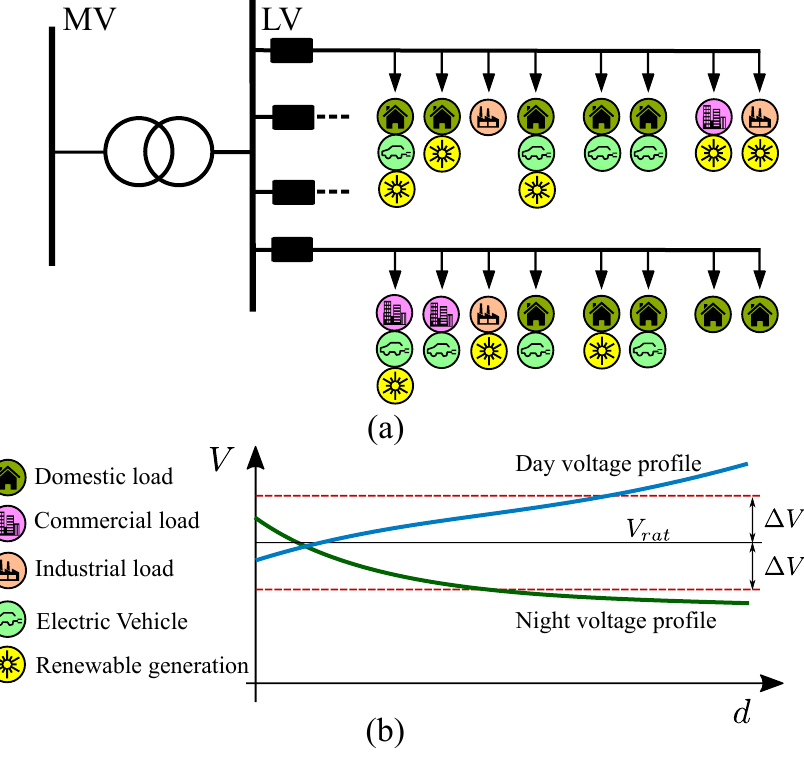
Figure 2. Two-way LV distribution feeders: ( a ) one-line diagram; and ( b ) voltage profile along the